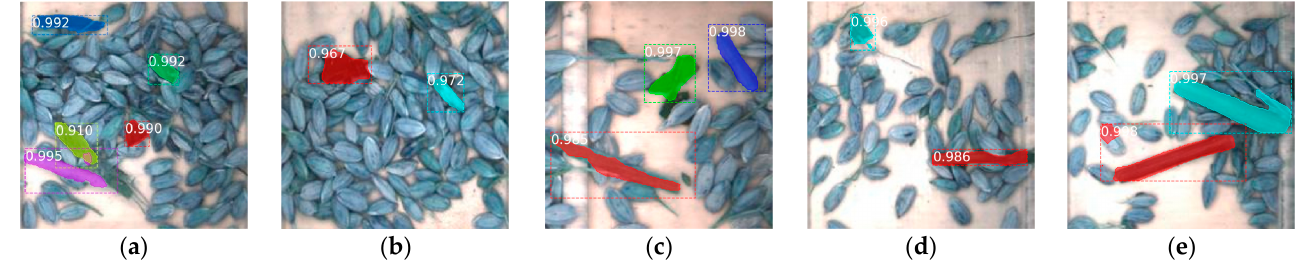
Figure 15. Impurity segmentation result. Masks are shown in color and confidences are also shown. ( a ) High impurity rate and dense rice; ( b ) low impurity rate and dense rice; ( c ) high impurity rate and sparse rice; ( d ) low impurity rate and sparse rice; ( e ) large size impurity.